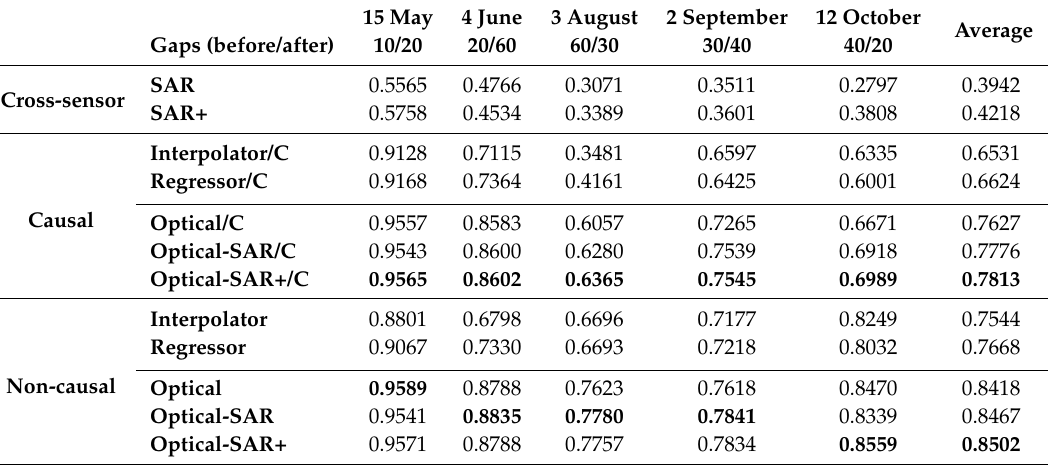
Table 6. Structural similarity measure (SSIM) [